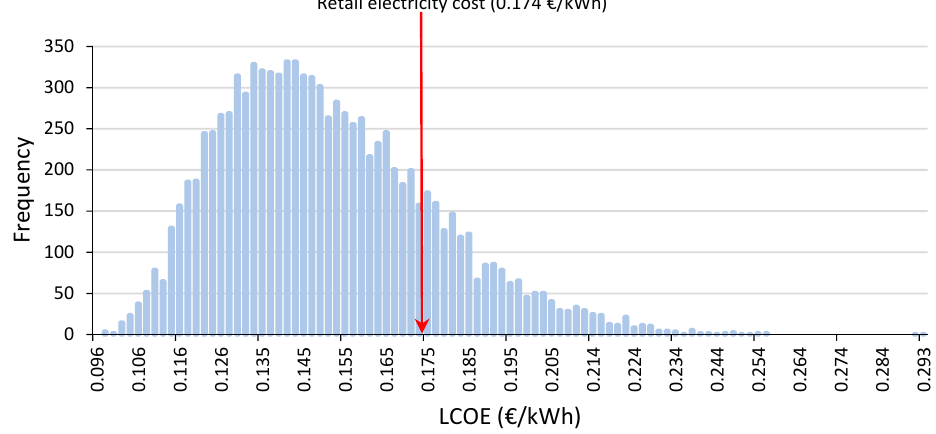
Figure 7. Histogram of the LCOE calculated with the Monte Carlo method for a 5 kW system.